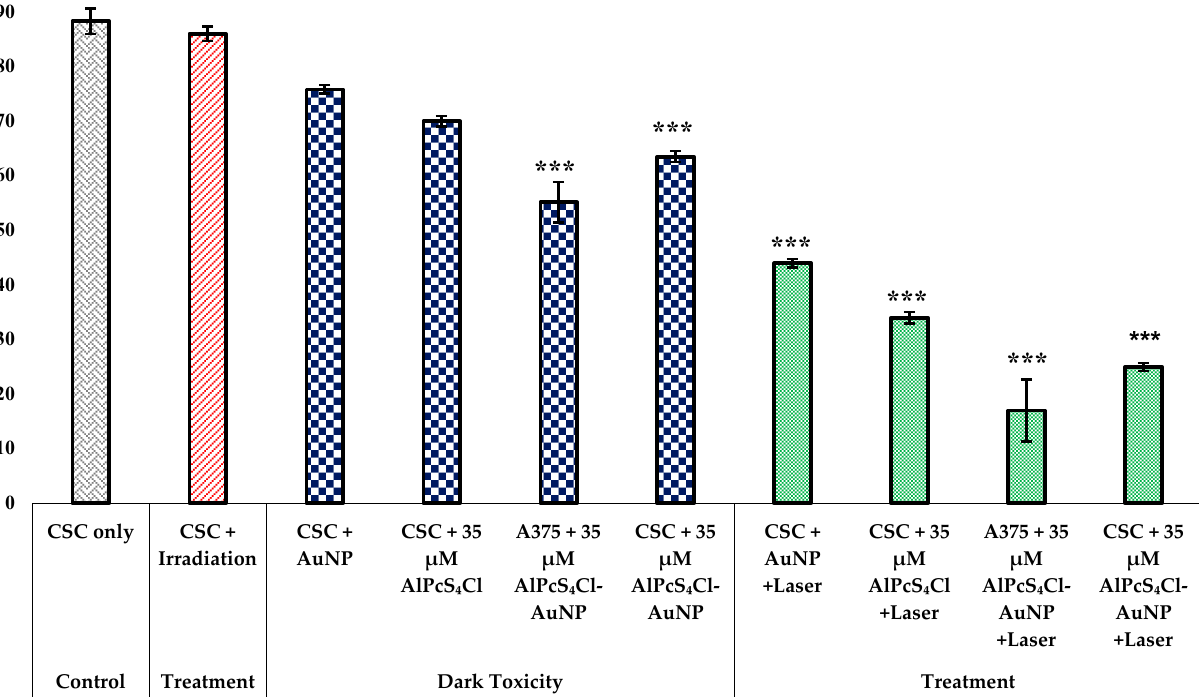
Figure 9. A375 CSCs trypan blue dye viability exclusion assay results for control, treatment, and dark-toxicity groups of increasing AlPcS 4 Cl dose and laser irradiation at 673 nm, radiant exposure: 5 J/cm 2 (significance denoted as *** p < 0.001). Cell viability decreased in laser-treated groups with PS-AuNP conjugate. The viability decreased in both cell lines compared to non-conjugated groups.